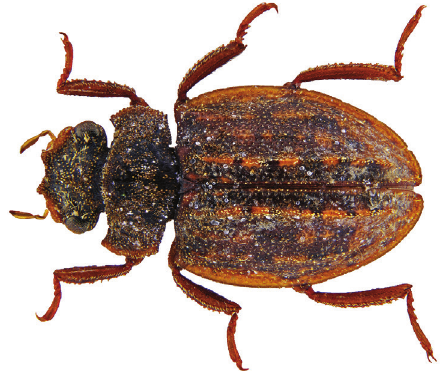
Figure 9. Spercheus senegalensis Castelnau, 1832 4.5 mm, iSimangaliso Wetland Park, False Bay (site 29), February 2015 DT Bilton, MS Bird & R Perissinotto